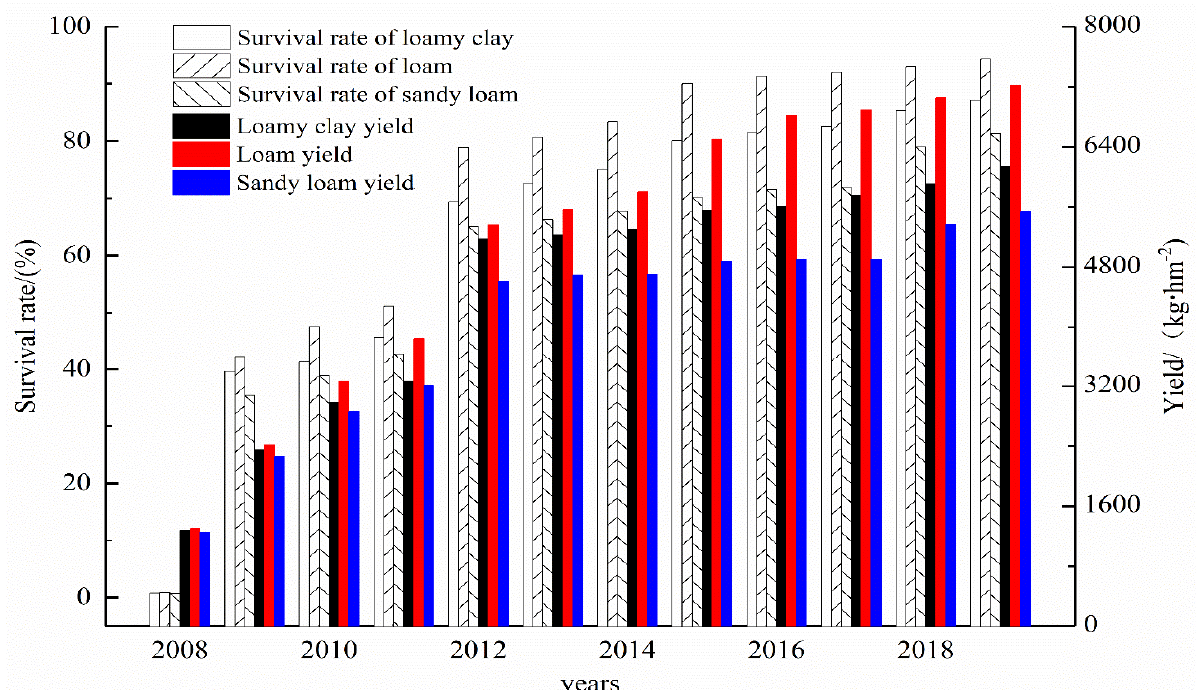
Figure 6. Changes in survival rate and yield of cotton in different soils.